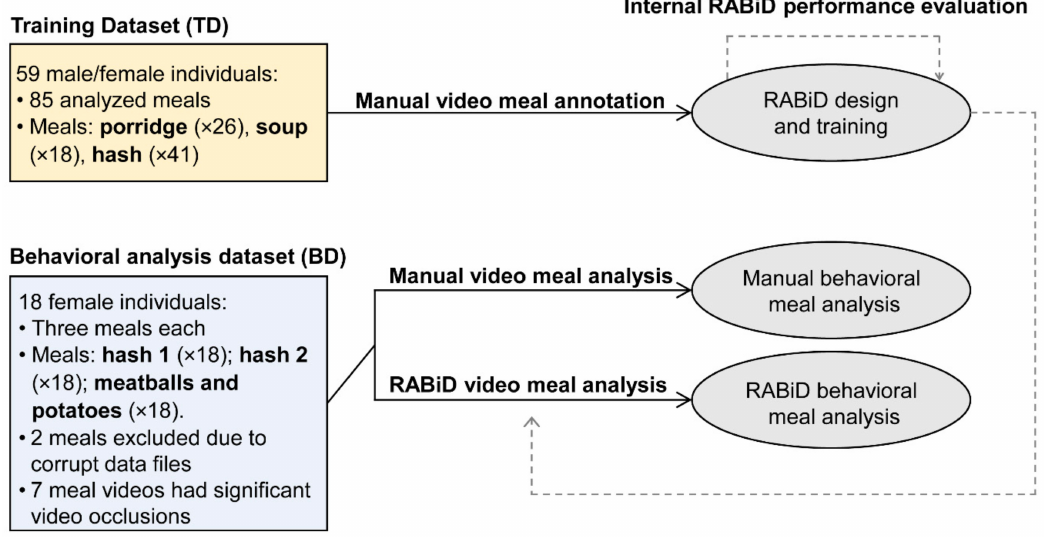
Figure 1. Schematic representation of the experimental design. The training dataset was used for the design, training, and internal performance evaluation of Rapid Automatic Bite Detection (RABiD). RABiD was later used to analyze the behavioral analysis dataset and the outcomes of this analysis were compared with the analysis outcomes based on manual video